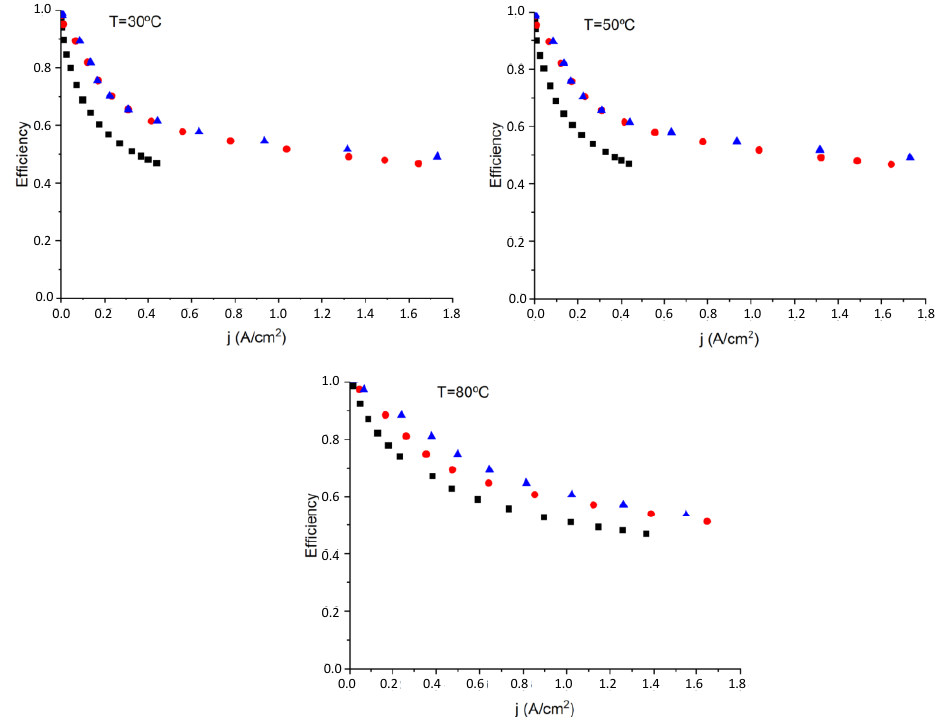
Figure 9. Efficiency variation obtained from thermoneutral voltage of the membranes MF-4SC ( ■ ), MF-4SC-PANI* ( ⬤ ), and MF-4SC-PANI** ( ), respectively, at different temperatures: 30, 50, and 80 °C, respectively.